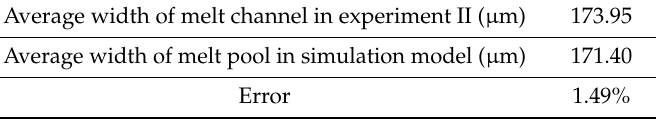
Figure 15. Single-channel scan experiment at P = 100 W. Table 6. Comparison between average width in experiment II and the model melt-pool width.